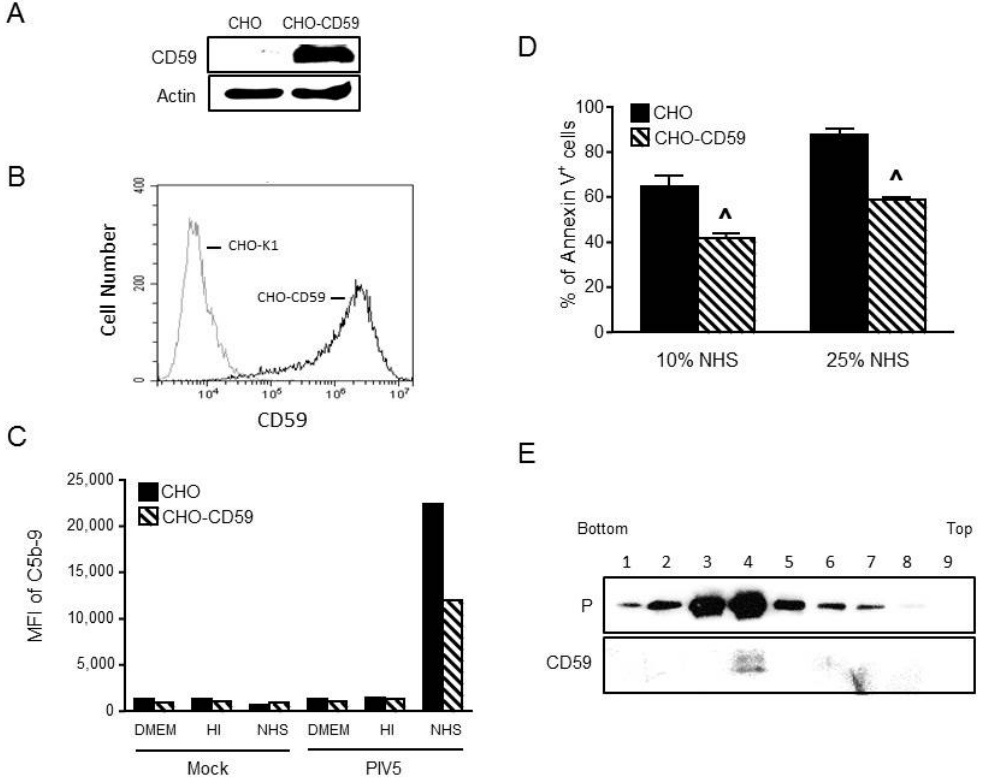
Figure 2. CHO cells expressing CD59 are functional in limiting MAC formation. ( A , B ) Parental CHO or CHO cells stably expressing CD59 were analyzed for CD59 expression by Western blotting (panel ( A )) or by flow cytometry (panel ( B )). In panel ( A ), levels of actin were analyzed as a loading control. ( C ) CHO and CHO-CD59 cells were mock infected or infected with PIV5 at an moi of 10. At 2 dpi, cells were treated with DMEM as a negative control and HI NHS or NHS at a dilution of 1:10 for 1 h. Cells were analyzed for levels of cell surface C5b-9 by flow cytometry. Results are representative of two independent experiments. ( D ) CHO or CHO-CD59 cells were infected with PIV5 at an moi of 10. At 2 dpi, cells were treated with 10% or 25% NHS for 4 h followed by Annexin V staining and quantitation by flow cytometry. Data are from three independent reactions and error bars represent standard deviation. ^ p < 0.01 when comparing PIV5 infected CHO-CD59 cells to PIV5 infected CHO control cells. ( E ) PIV5 derived from CHO-CD59 cells was sedimented through a 20% to 60% sucrose gradient. Fractions were collected and analyzed by Western blotting for viral P protein or for CD59.